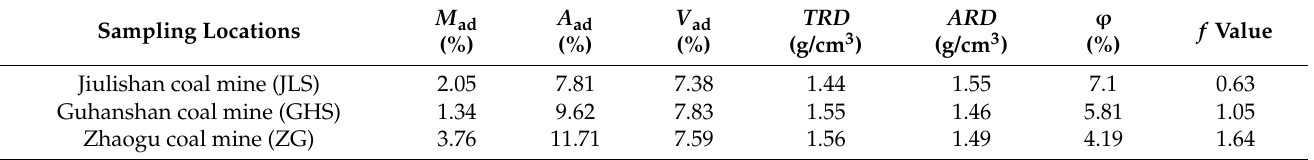
Table 1. Basic parameters of coal samples.